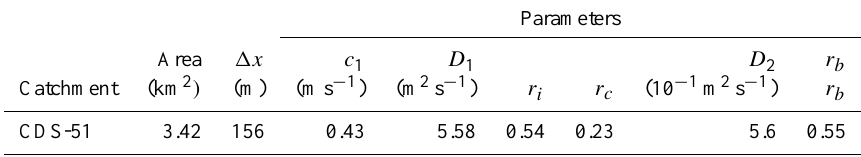
Table 4. Parameter values estimated for CDS-51.